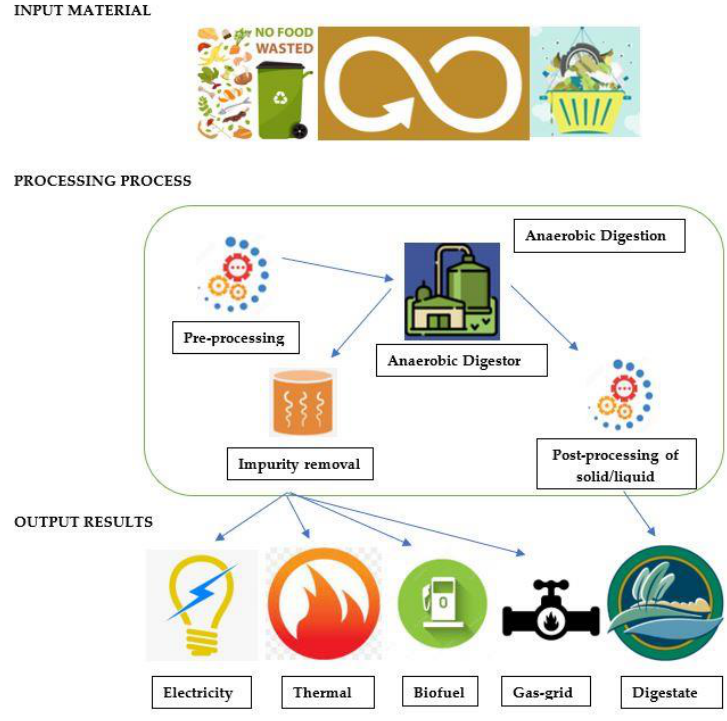
Figure 4. Anaerobic Digestion System (modified after [60]).